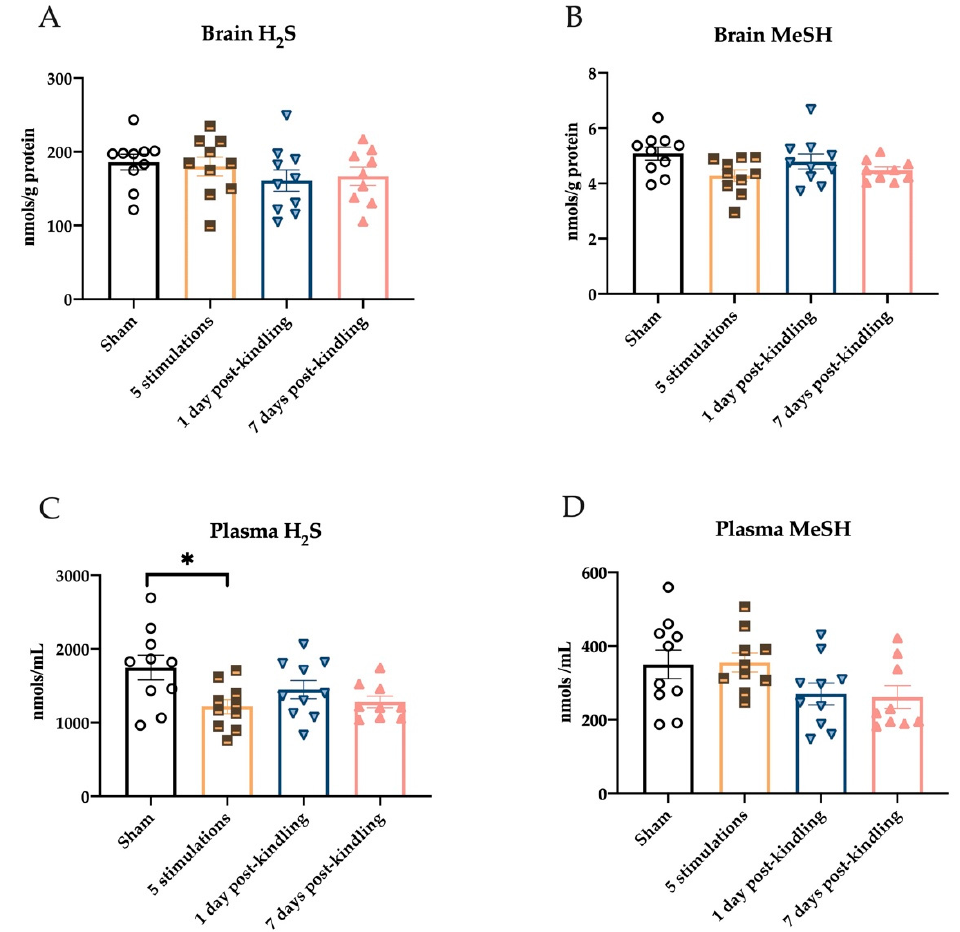
Figure 4. The levels of H 2 S and MeSH are quantified in the brains and plasma of male mice with time after induction of the corneal kindled model of temporal lobe epilepsy. Data are presented as mean +/ − S.E.M. ( A ) Changes in whole brain H 2 S levels were not significantly affected by the 60 Hz transcorneal stimulation needed to induce the fully kindled state. ( B ) The levels of MeSH in the whole brain were not significantly reduced post-kindling. ( C ) The levels of H 2 S in purified plasma were significantly reduced in mice euthanized 1 h after the fifth transcorneal stimulation, but levels were no different from sham-kindled mice when assessed 1 day or 7 days post-kindling. ( D ) The levels of MeSH in the plasma were not significantly different from sham-kindled mice. * Indicates significant difference from sham-kindled mice, p < 0.05.